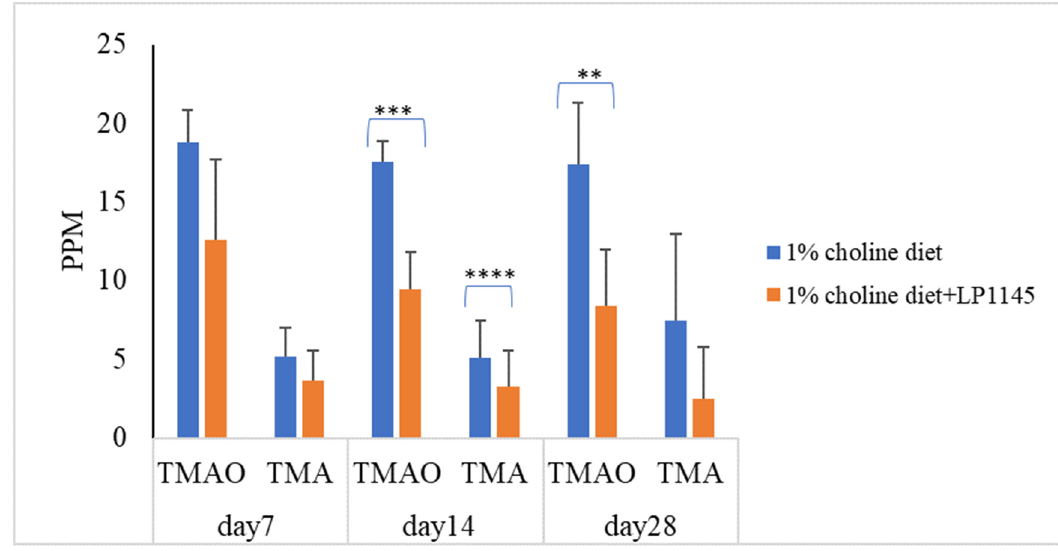
Figure 2. Probiotic strain Lpb. plantarum decreases the plasma TMAO and TMA levels in C57BL/6J mice. Experimental conditions were as described in Methods. Data are expressed as mean values ± SD ( n = 7). * p <0.05, ** p < 0.01, *** p <0.001, **** p < 0.0001.